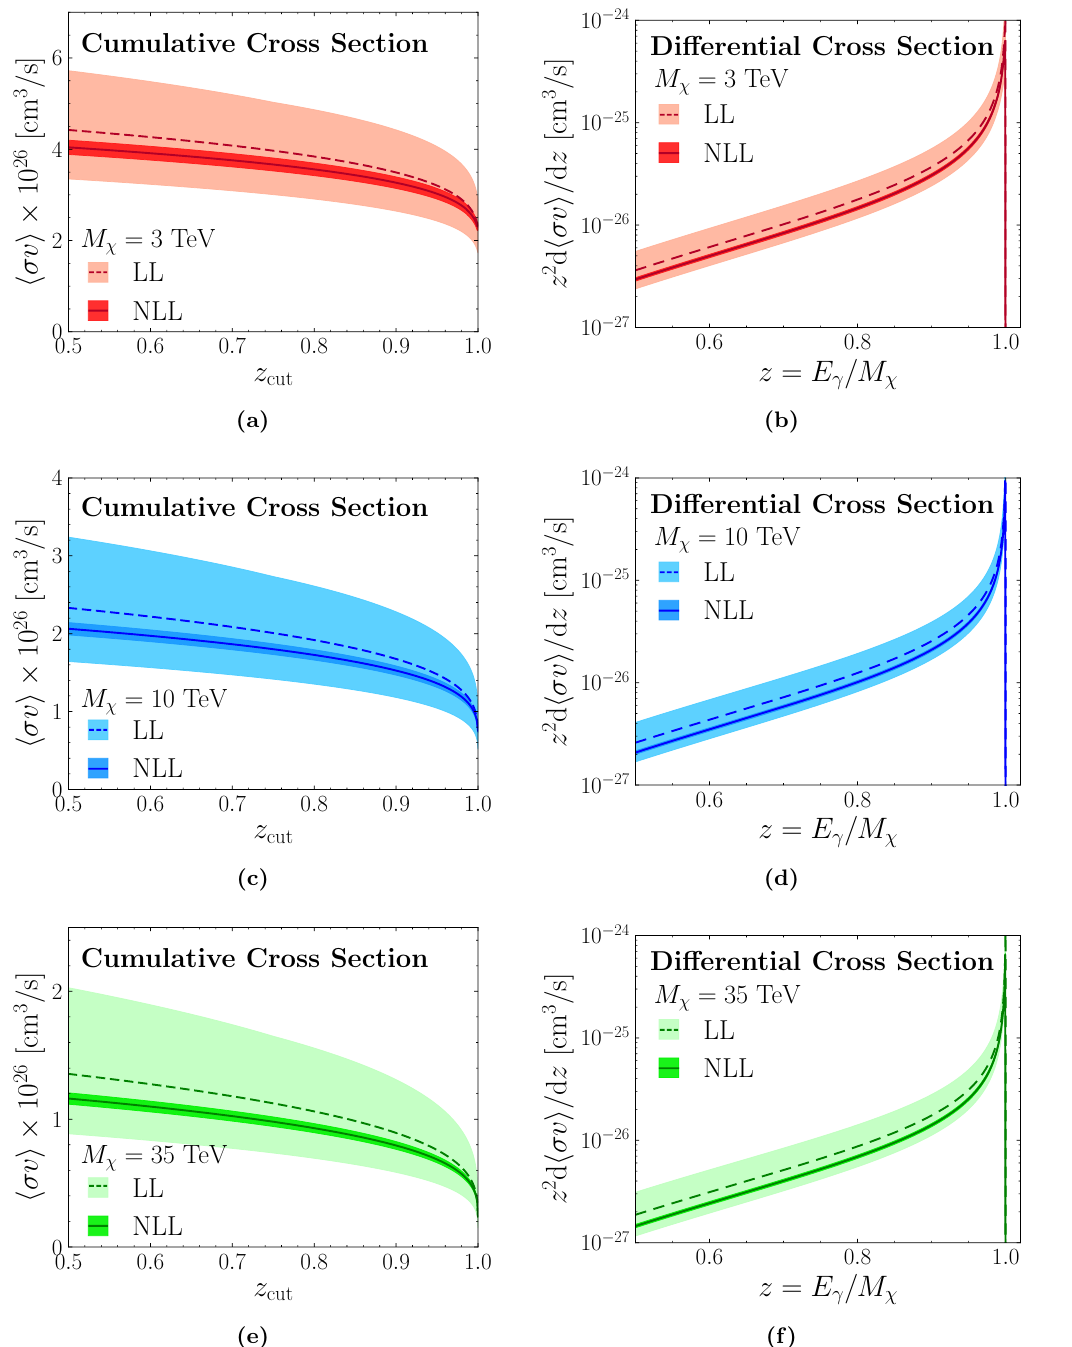
Figure 9 . The cumulative (left column) and z 2 weighted di(cid:11)erential (right column) spectrum for wino annihilation in the endpoint region. Spectra are shown for three di(cid:11)erent wino masses, 3, 10 and 35 TeV, at both LL and NLL accuracy. Theoretical uncertainties obtained by scale variation are shown by the shaded bands | the uncertainty bands are hardly visible at NLL at high